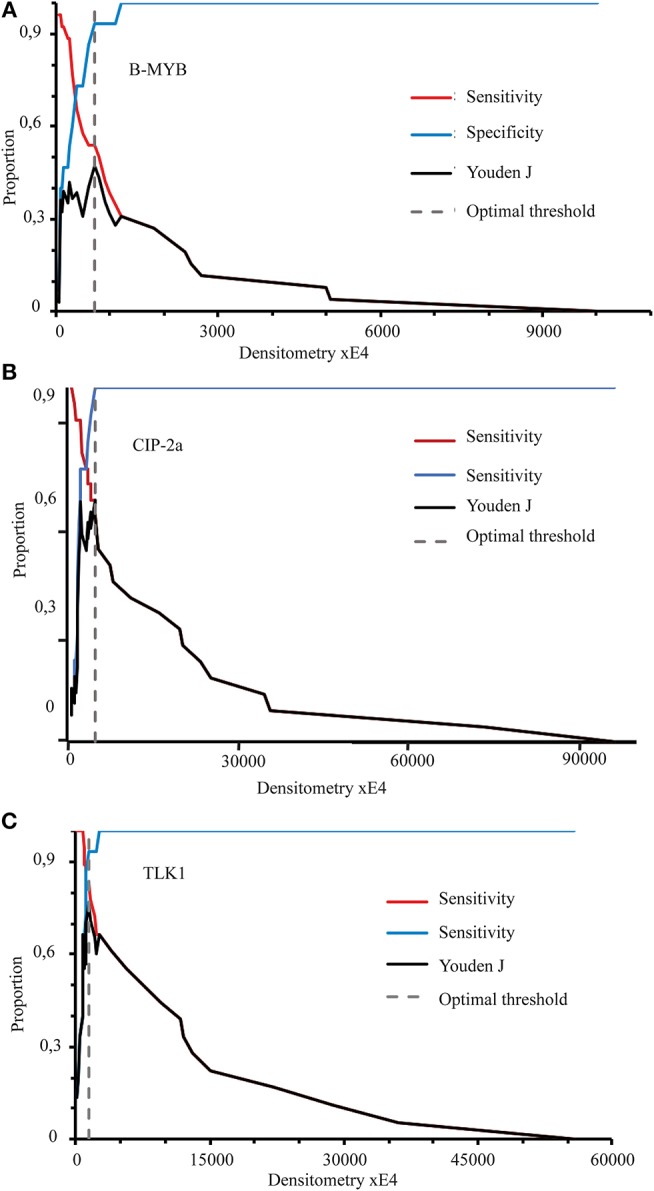
The concurrent changes in the proportion values of Sensitivity, Specificity, and Youden's J index (Youden's statistic) in relation to increasing densitometric integrated intensity values (xE4) of each specific protein band (A-C) examined. Optimal Decision Thresholds (ODTs) of the densitometric intensity values for each putative biomarker tested are indicated by vertical dashed lines and coincide with the highest value of the corresponding Jouden's J index.